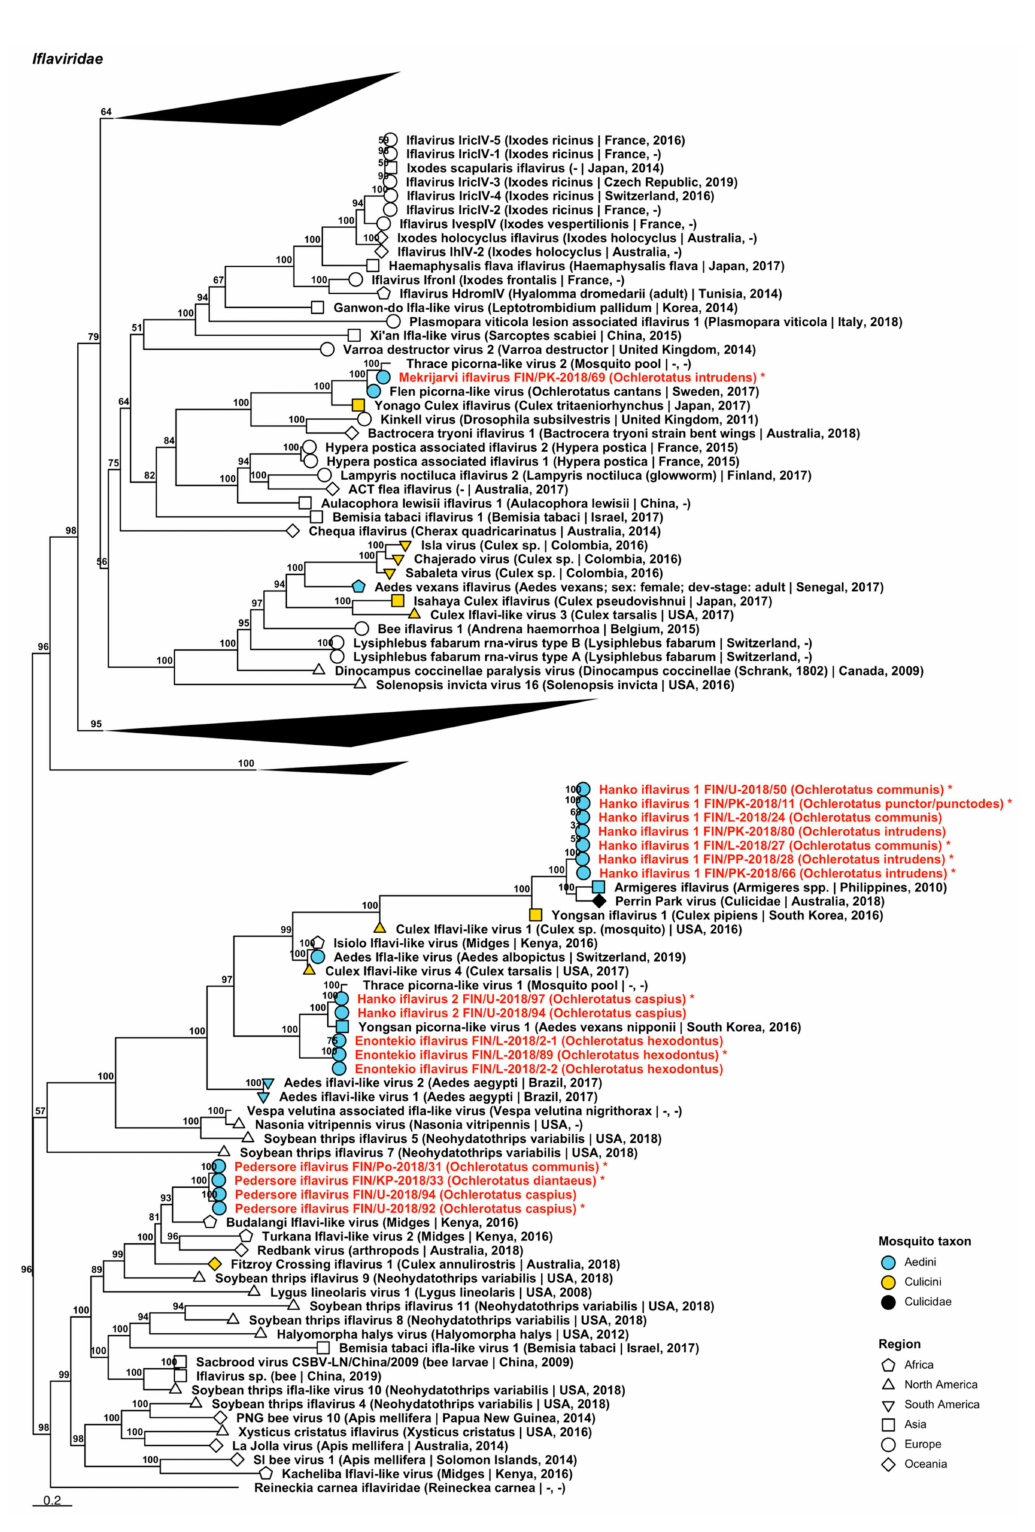
Figure 4. Maximum likelihood tree of Iflaviridae . Tentative novel virus species are displayed in red and the mosquito species from which they were derived are in parentheses. Sequences from GenBank are black and display the following information after the virus or species name: “(sampled organ- ism(s)|collection country, collection year)”. Tip colours represent the tribe of mosquito from which viruses were obtained. Tip shape represents the continent or region from which the specimens were collected. Trees were constructed from amino acid sequences of virus polymerases >1000 nt, aligned with MAFFT and computed with IQ-TREE2 using ModelFinder and 1000 bootstraps. Asterisks denote that the complete genome was